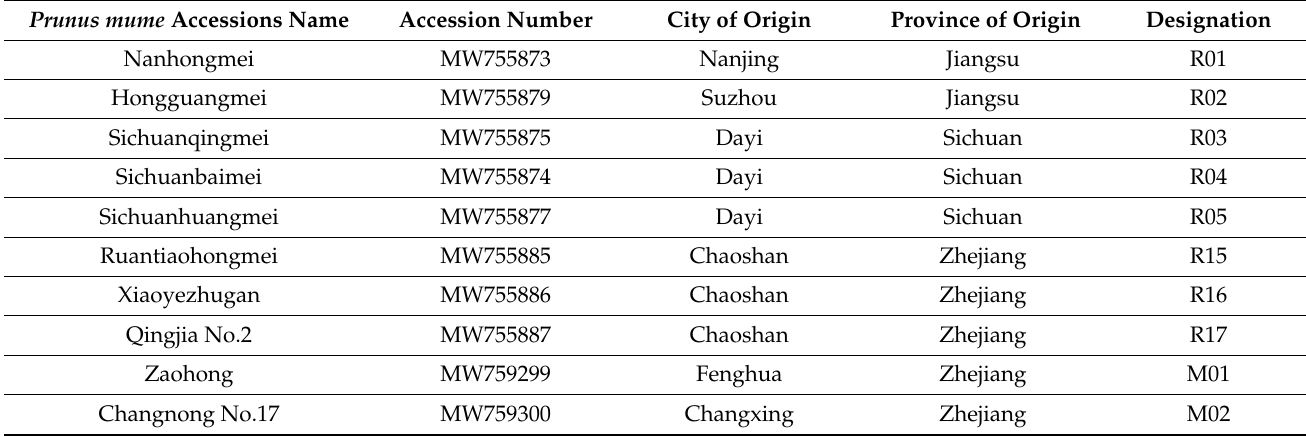
Table 1. Accessions name, accession number and origin of the two newly sequenced and eight previously sequenced Japanese apricot ( Prunus mume ) accessions available at Nanjing Agricultural